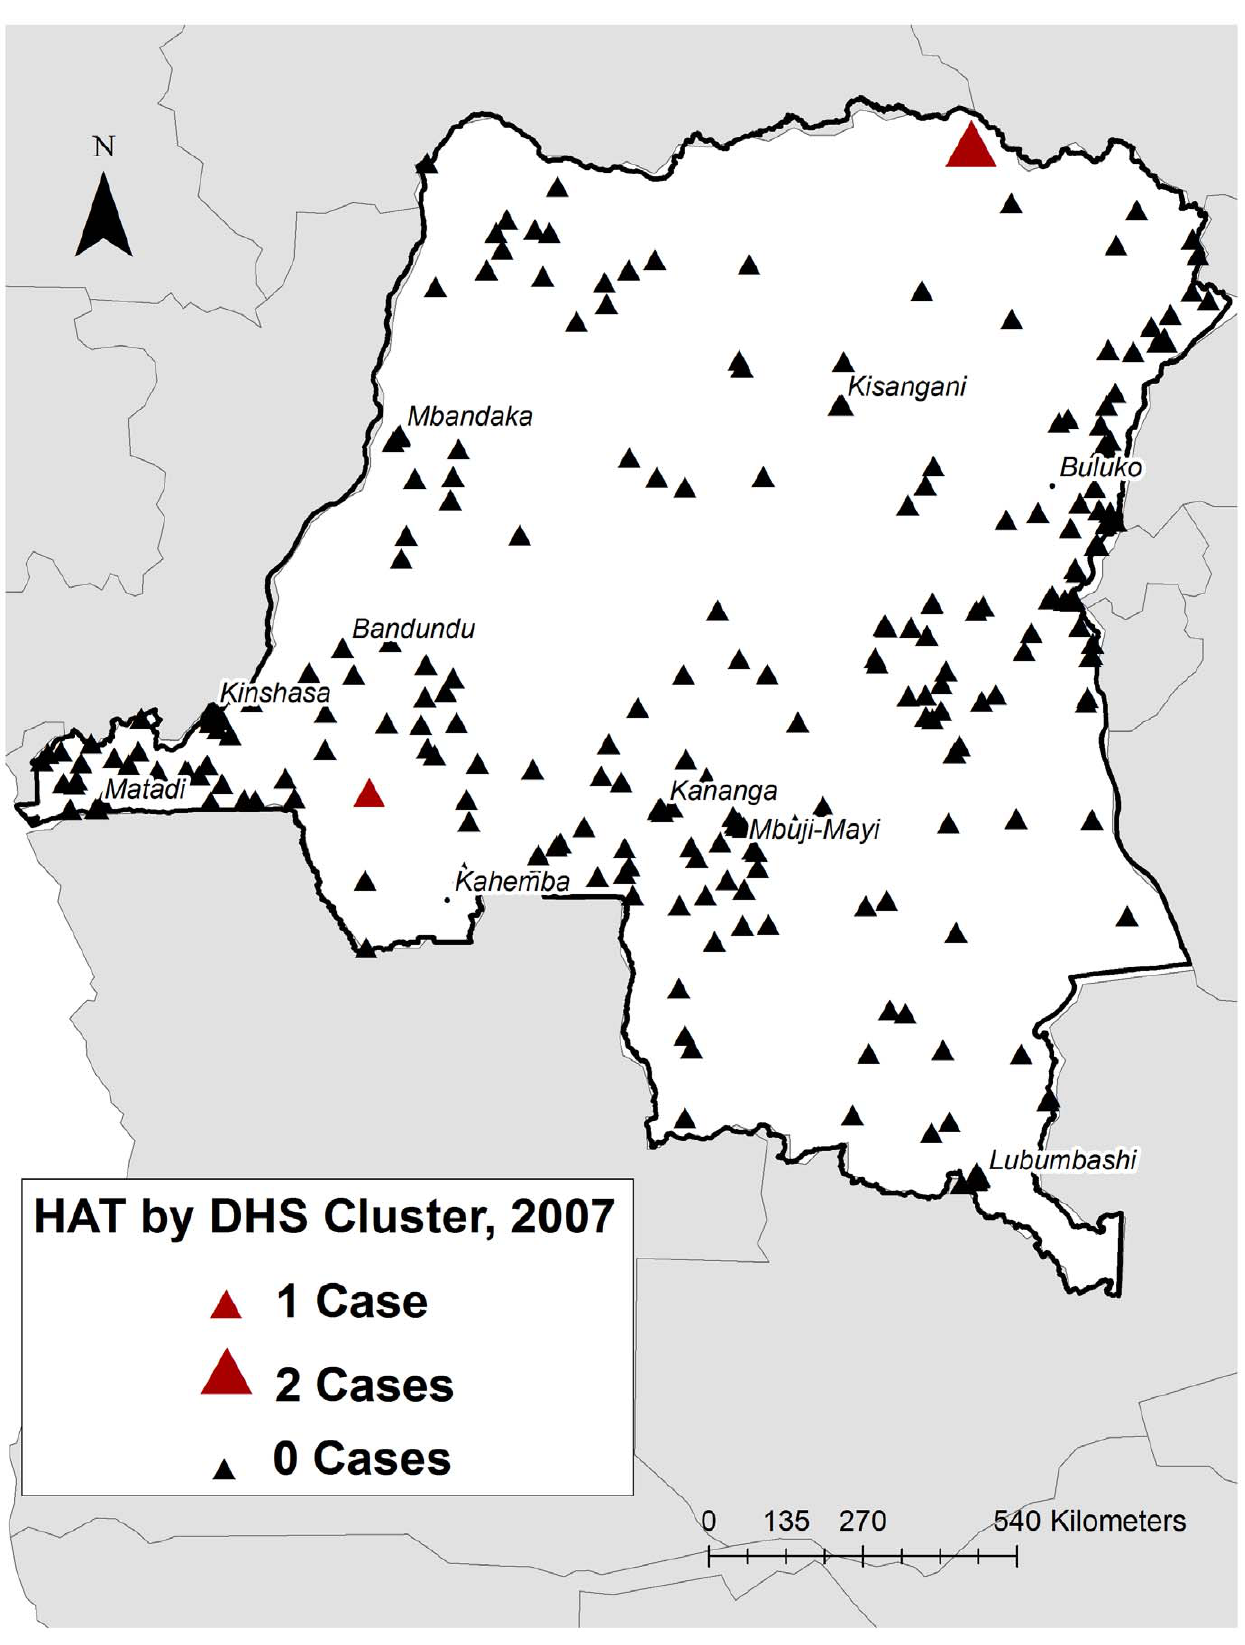
Figure 1. Map of the 300 sites from which dried blood spots were obtained and where the positive cases were detected.